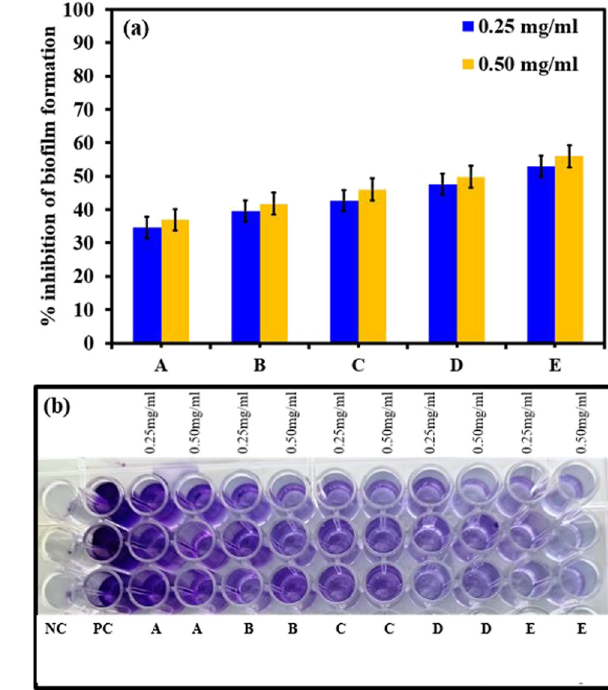
Figure 7: ( a ) E ff ects of nanocomposites on bio fi lm formation abil - ities of S. aureus and ( b ) 96 - well microtiter plate showing bio fi lm inhibition of S. aureus in the presence of nanocomposites. Negative control ( NC ) : culture media only, without bacteria and nanocompo - sites; positive control ( PC ) : culture media inoculated with S. aureus , but without nanocomposites: bio fi lm inhibition in the presence of 0.25 and0.5mg/mLofnanocomposites ( A = g - C 3 N 4 ,B = 2.5% - n - NiO@g - C 3 N 4 , C = 5% - n - NiO@g - C 3 N 4 , D = 10% - n - NiO@g - C 3 N 4 , and E =